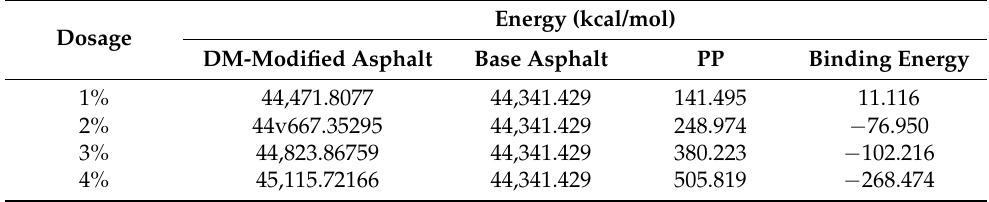
Table 7. Binding energy of DM-modified asphalt (331